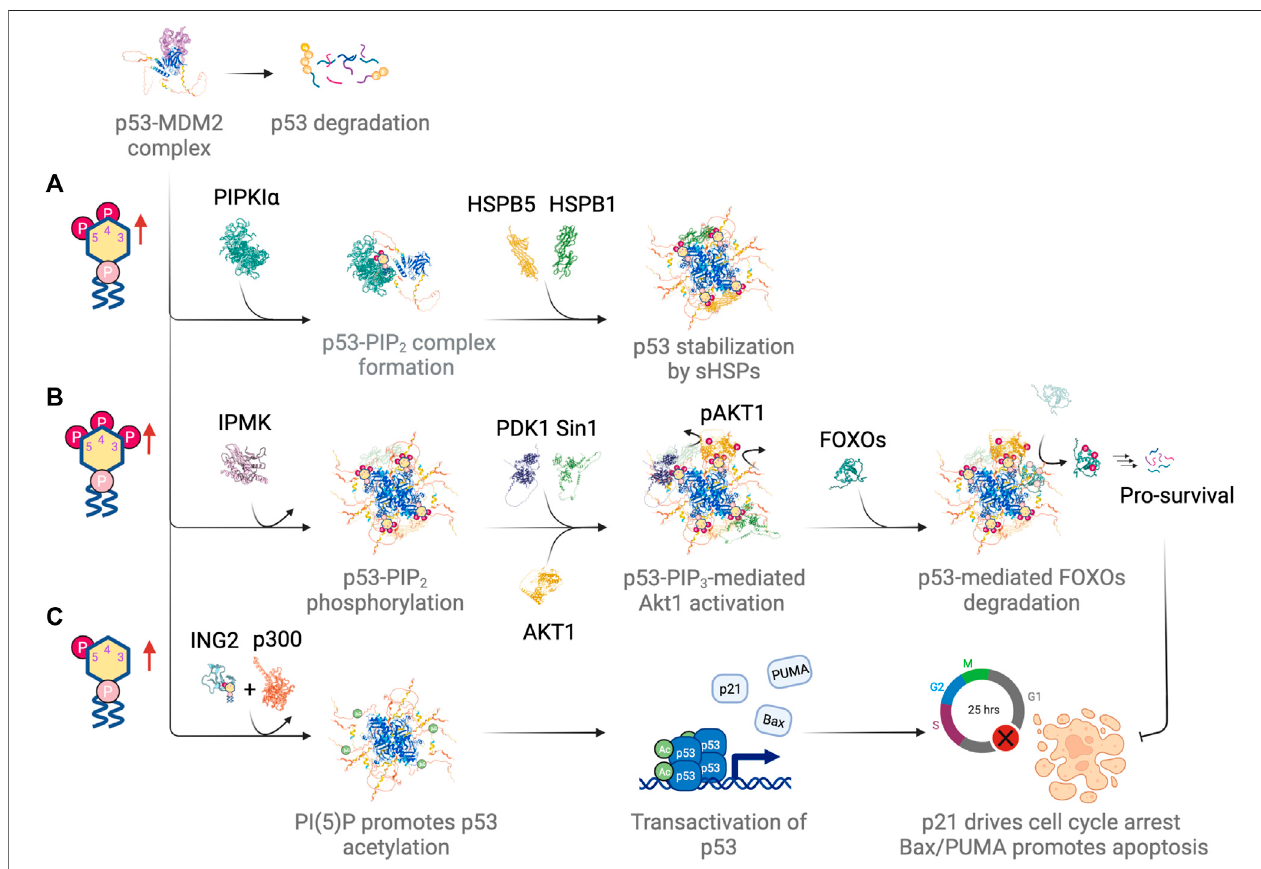
FIGURE 5 | Differential regulation of p53 by different nuclear phosphoinositide species in response to DNA damage. (A) PI(4,5)P 2 drives complex formation with p53 and promotes p53 stabilization by recruiting small heat shock proteins (sHSPs). (B) IPMK phosphorylates p53-PI(4,5)P 2 complex, which serves as a signaling hub for Akt activation and subsequent phosphorylation and degradation of FOXOs. (C) PI(5)P promotes chromatin association of ING2. It drives p300-mediated acetylation and transactivation of p53. Figures created with BioRender.com.